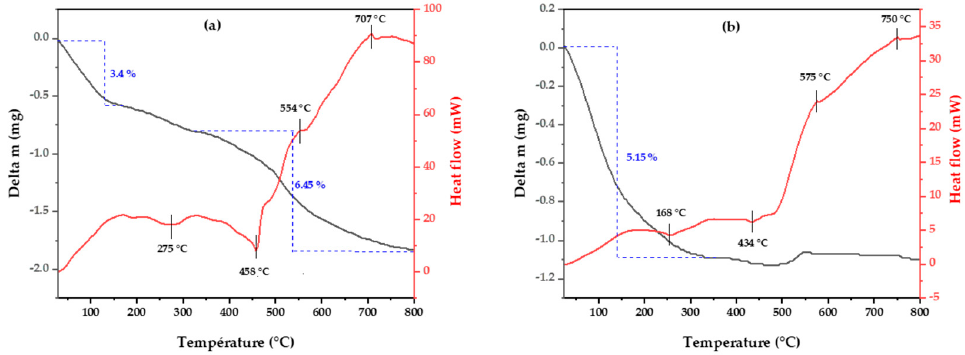
Figure 5. TGA/DSC curves of Cs 5 PMo 11 FeO 39 ( a ) and Cs 5 PMo 11 CoO 39 ( b ).